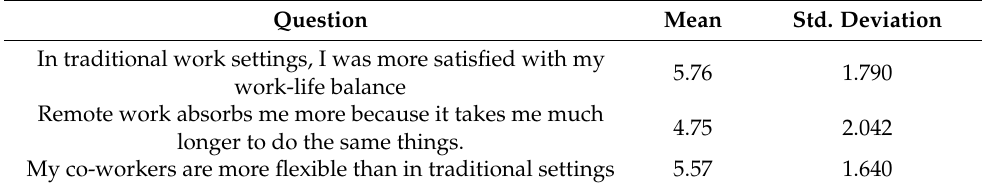
Table 4. Descriptive